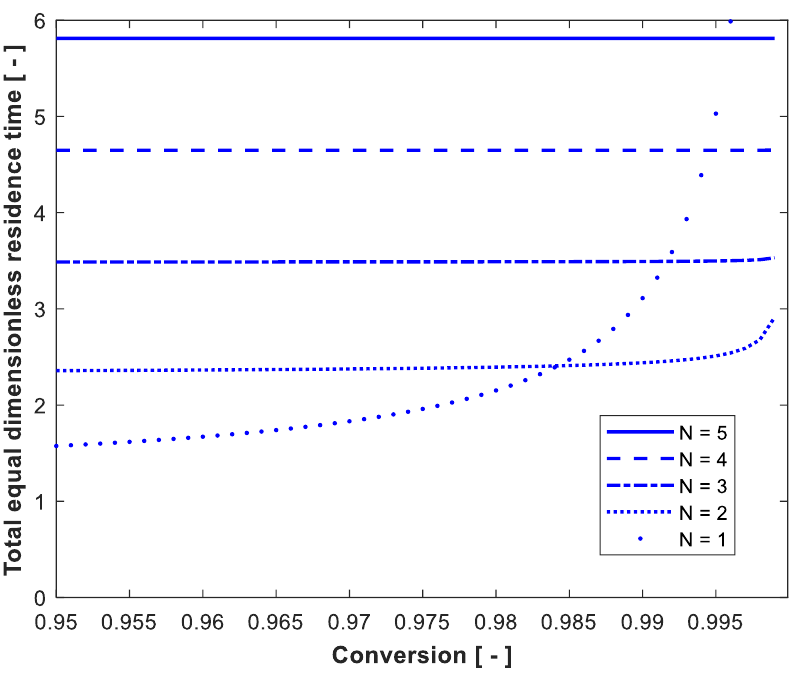
Figure 8. Effect of substrate conversion on the total dimensionless residence time of equal-volume reactors in series. X o = 0. S o = 30 g/L. P o = 0. N = 1 is shown for comparison.